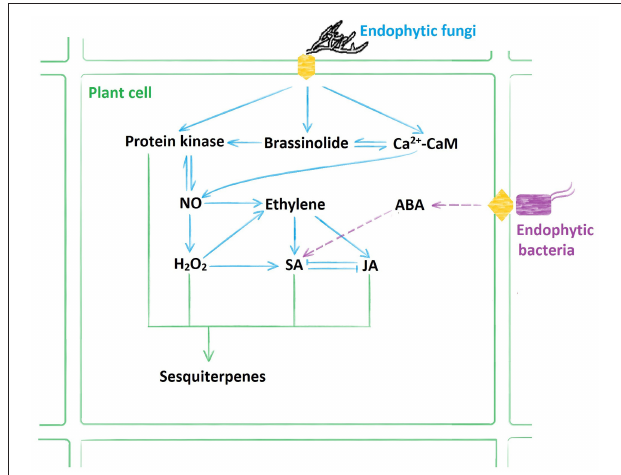
FIGURE 7 | Model illustrating multiple signaling pathways involved in sesquiterpenoids biosynthesis induced by the endophytes. The endophytic fungus AL12 induced sesquiterpenoids biosynthesis through NO, H 2 O 2 , ET, SA, JA, brassinosteroid (BR), and calcium (Ca 2 + ) signaling pathways; whereas the endophytic bacteria ALEB16 induced sesquiterpenoids biosynthesis through abscisic acid (ABA) and SA signaling